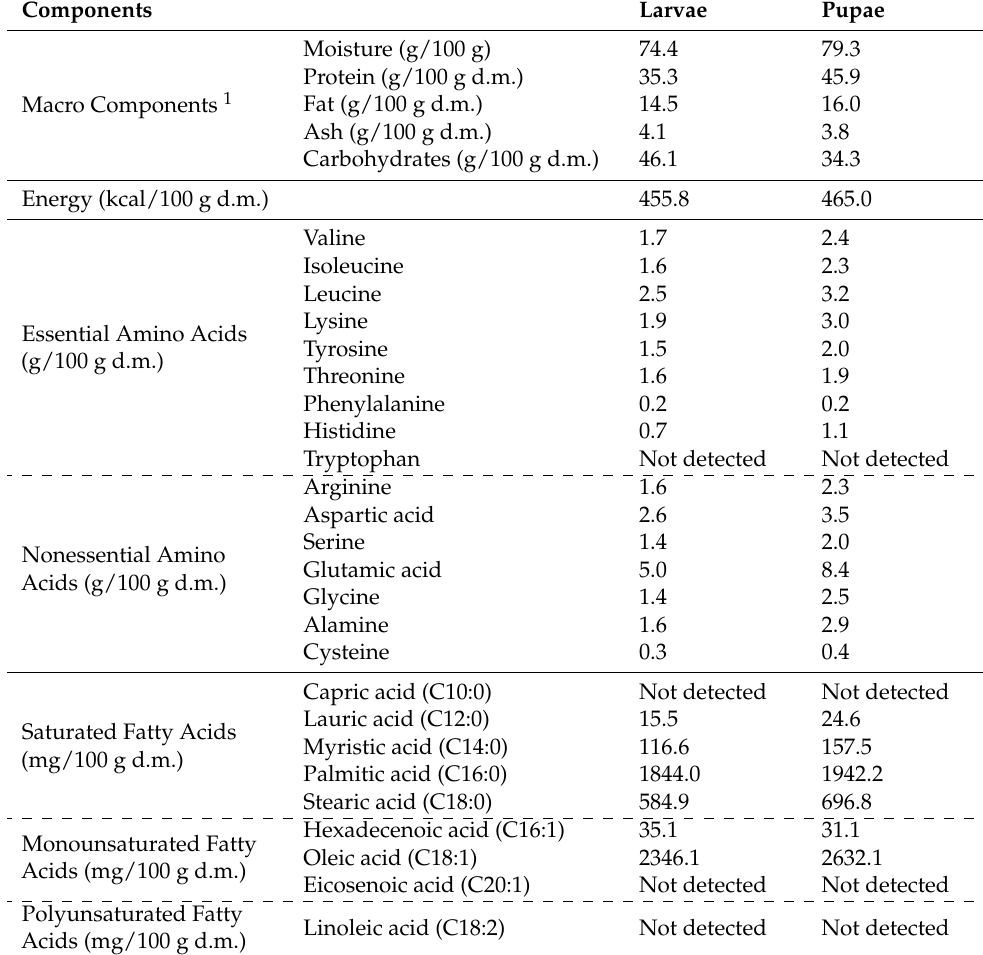
Table 2. Nutritional composition of larvae and pupae of Apis mellifera ligustica worker bees [36].